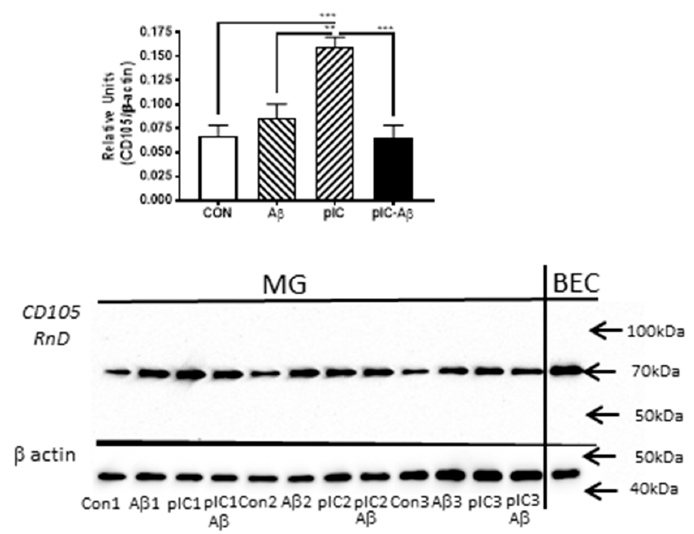
Figure 8. Levels of CD105–70 kDa polypeptide in in vitro-stimulated human brain microglia. Top panel: Bar chart showing mean levels of CD105 70 kDa polypeptide in stimulated human microglia. Microglia were stimulated with A β (42)(2 µ M), poly IC (pIC) (25 µ g / mL) or combination of both (pIC-A β ) in triplicate for 24 hours and analyzed by Western blotting. Significant increase in 70 kDa in pIC-stimulated but not A β -stimulated microglia. Results normalized against values for β -actin. This is representative of 3-independent experiments with di ff erent microglia isolates. *** p < 0.001; ** p < 0.01. Lower panel: Western blot showing bands in treated microglia (MG). The same 70 kDa band was detected in sample of brain endothelial cells (BEC) isolated from same case. Blots were reprobed with antibody to β actin for normalization purposes.